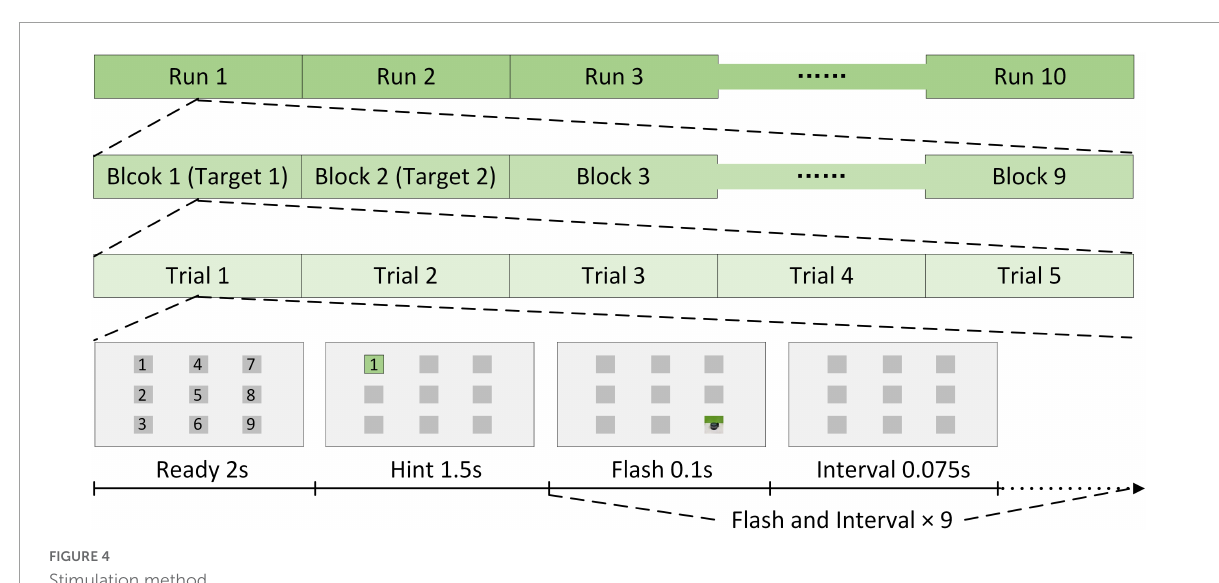
FIGURE4 Stimulation method.